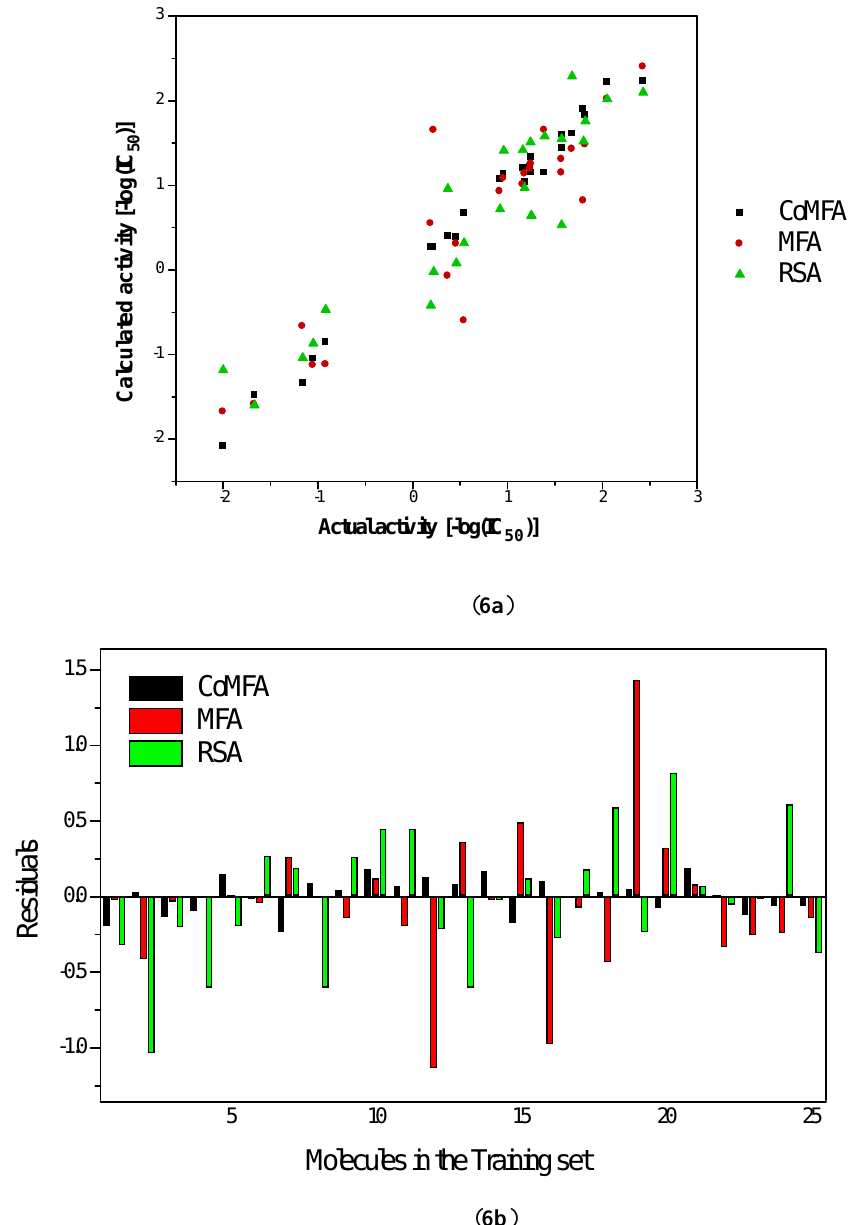
Figure 6. (a) Plot of actual vs. calculated biological activities of the training set molecules in the three methods of analysis. (b) Plot of residuals in the three methods of analysis. In general, CoMFA pro- duced a better